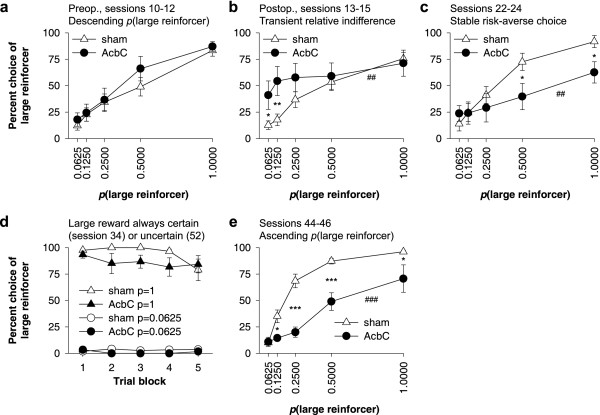
Choice with probabilistic reinforcement. (a) Preoperative patterns of choice. There were no differences between the groups preoperatively. (b) The first three postoperative sessions. Transiently, AcbC-lesioned rats exhibited relative indifference between the two alternatives; their preference did not differ significantly from 50% at any large-reinforcer probability. As a result, AcbC-lesioned rats preferred the large, unlikely reinforcer more than shams did when its probability was 0.0625 and 0.125 (## p < .01, lesion × probability interaction; * p < .05, ** p < .01, comparison to shams at individual probabilities). However, both groups were influenced by the large-reinforcer probability (p ≤ .004). (c) The last three postoperative sessions on the same basic task. By this point, AcbC-lesioned rats preferred the large reinforcer less when its probability was 0.5 or 1 (## p < .01, interaction; * p < .05, simple effects). Again, both groups were influenced by the large-reinforcer probability (p < .001). (d) When the 4-pellet reinforcer and the 1-pellet reinforcer were both certain, all groups preferred the 4-pellet reinforcer, and when the 4-pellet reinforcer was always very unlikely (delivered with a probability of 0.0625) and the 1-pellet reinforcer was certain, all groups preferred the 1-pellet reinforcer, with no differences between AcbC-lesioned and sham-operated rats. This indicates that both groups discriminated the reinforcers themselves and discriminated their probability of delivery. (e) Choice following further training in which the large-reinforcer probability increased, rather than decreased, across each session. The pattern of choice is similar to c, in that AcbC-lesioned rats were risk-averse compared to shams, i.e. less likely to choose the large, unlikely reinforcer (### p < .001, interaction; * p < .05 and *** p < .001, simple effects). The similarity to c, despite the reversed task order, also indicates that subjects' choice reflected the probabilities in force rather than the order within a session.